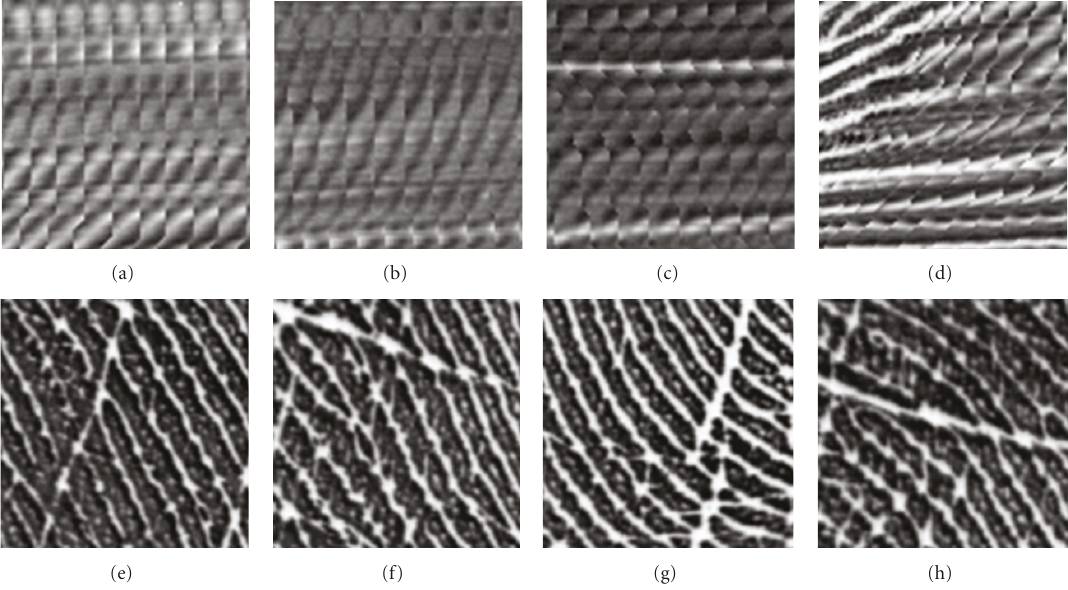
Figure 4: Defective tissue versus normal tissue. (a)–(d) defective tissues and (e)–(h) normal tissues.